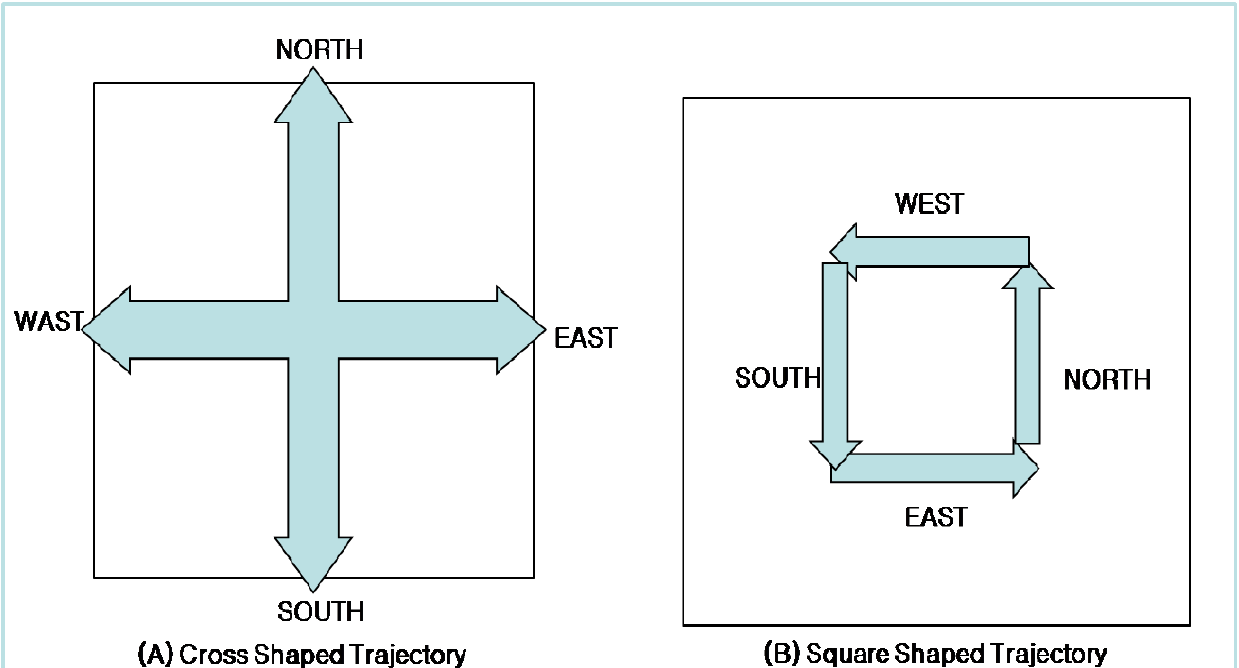
Figure 4. Cross Shaped Trajectory and Square Shaped